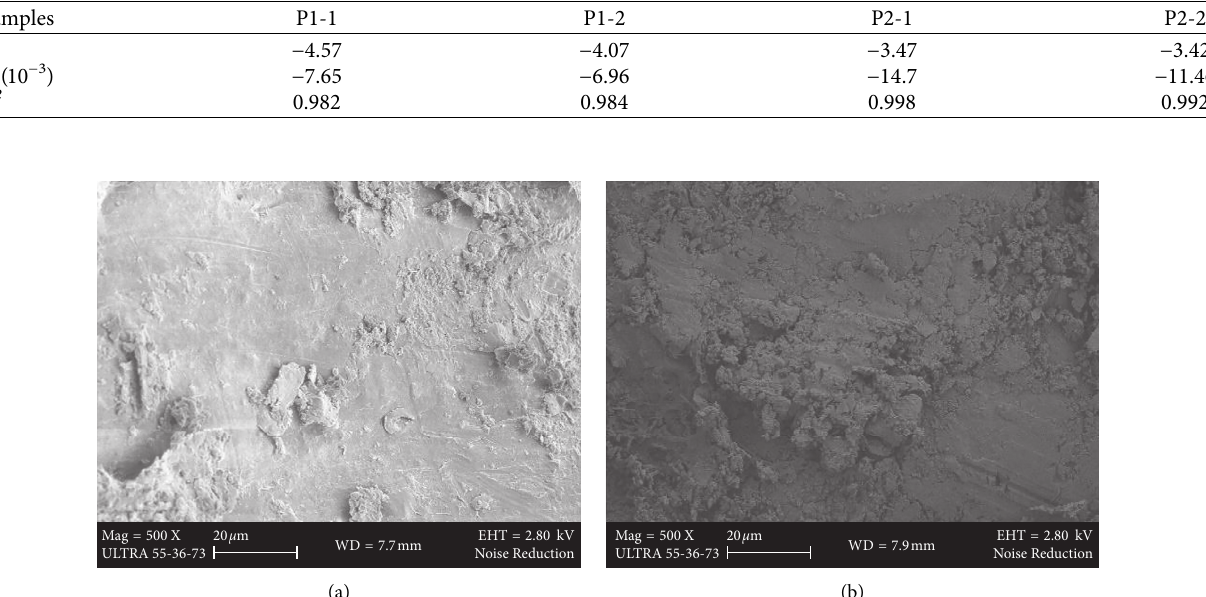
Figure 6: SEM images of plastic and textile in MBT waste captured at a magnification of 500. (a) Plastic. (b) Textile.